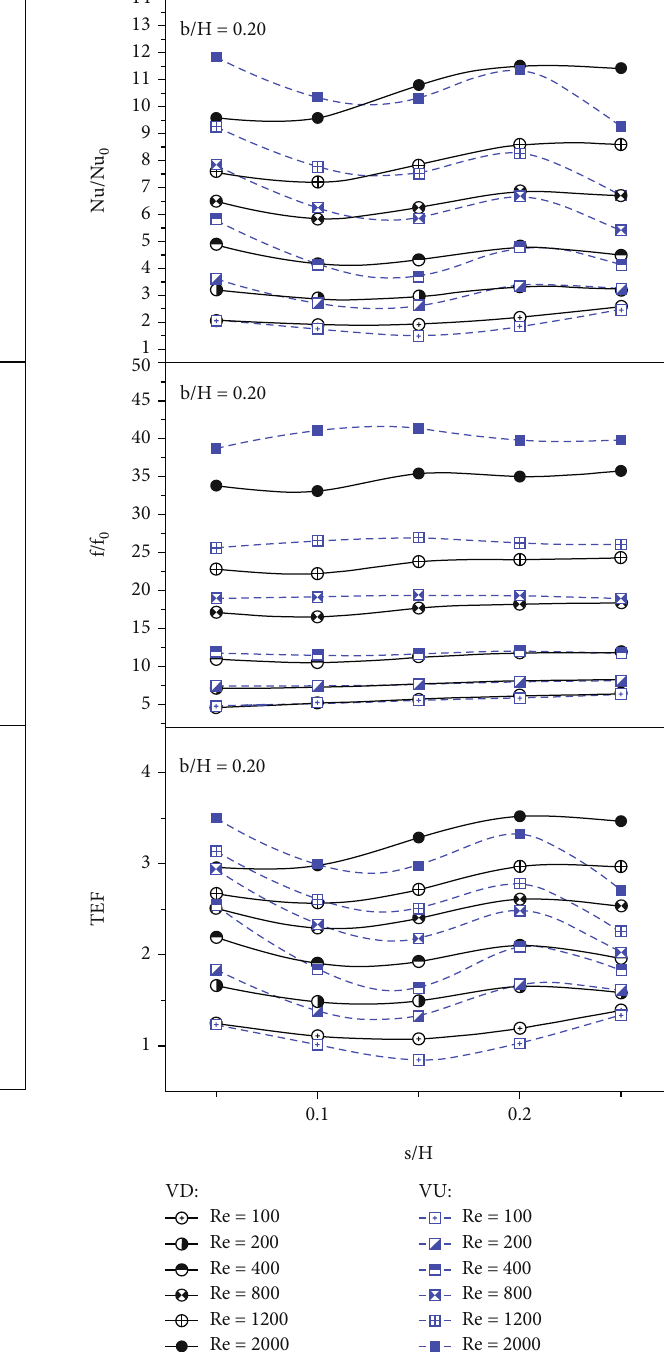
Figure 11: Thermal performance analysis of b / H = 0 : 15 . Figure